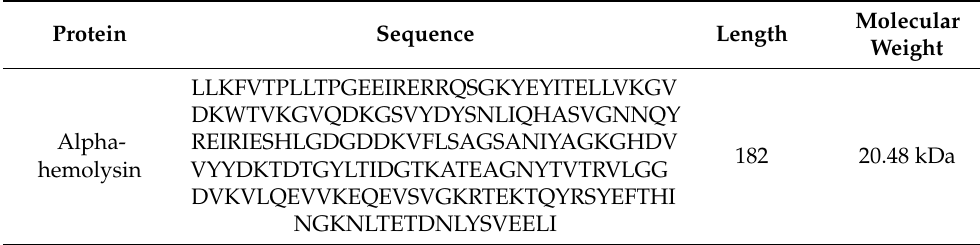
Table 2. Alpha-hemolysin antigenic region sequence.